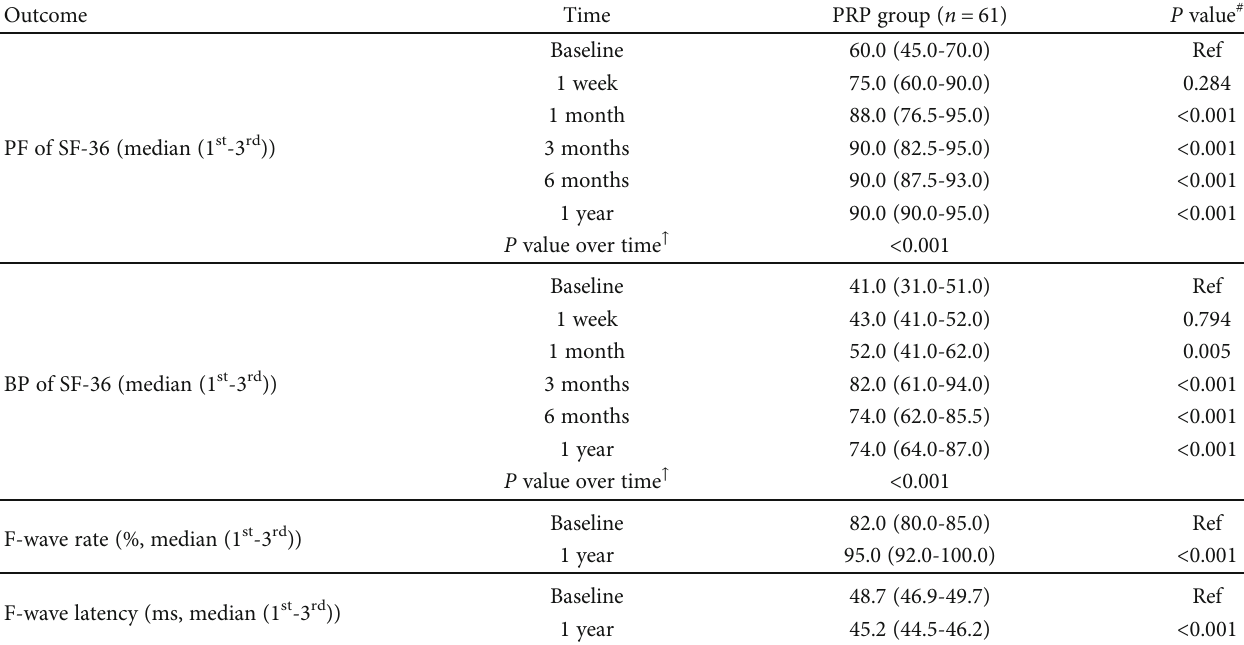
Table 3: Longitudinal outcomes of life quality and nerve function for the PRP group over time.